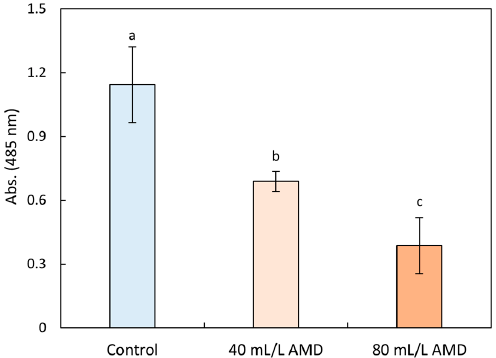
Figure 4. TPF absorbance of seeds exposed in AMD for 48 h. (Different letters, a, b, and c, represent statistical differences between treatments; the error bar represents standard deviation; Fisher LSD multiple comparison; p < 0.05 level; N ＝ 6).